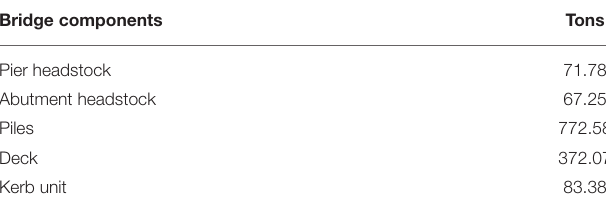
TABLE 1 | Bridge components and